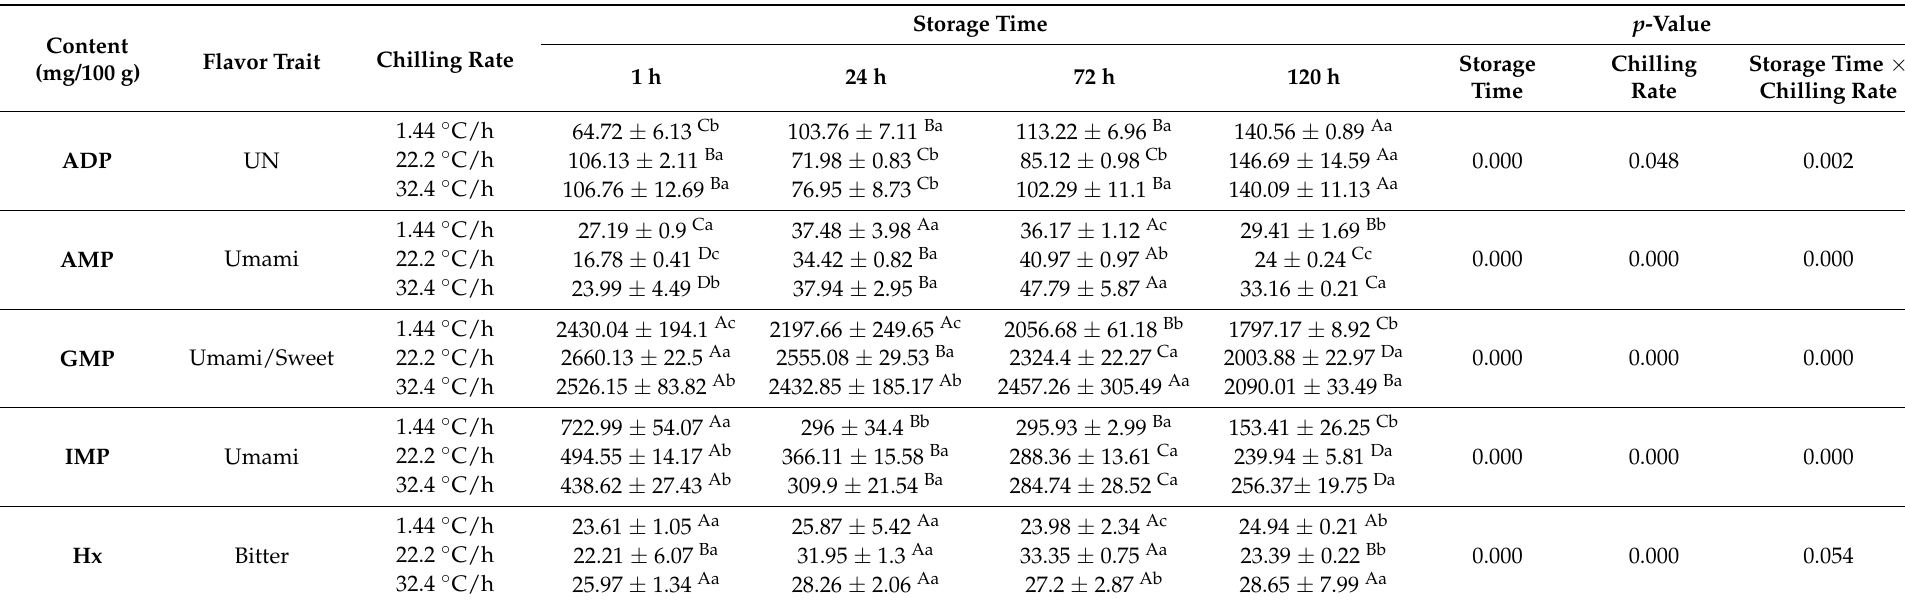
Table 3. Contents (mg/100 g) of 5 (cid:48) -nucleotides in raw meat at different chilling rates during